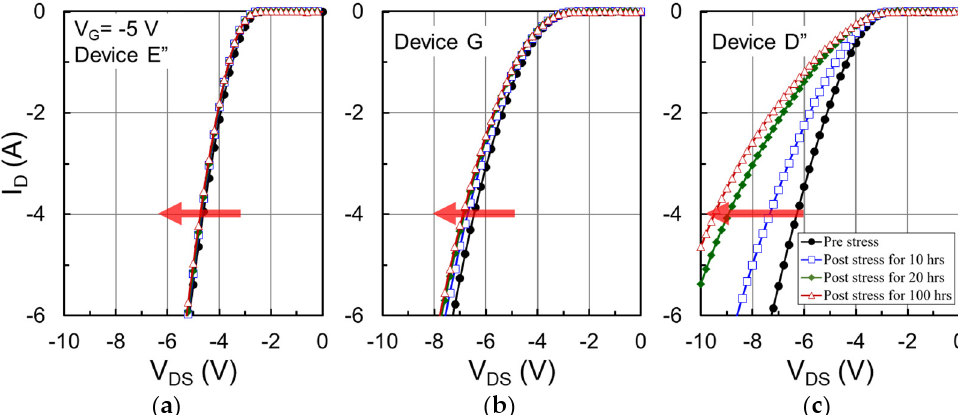
Figure 15. Third-quadrant I D -V D characteristics for built-in body diode of 1.7 kV SiC DMOSFET from three vendors. The body diodes were stressed at 5 A for ( a ) Device E” ( b ) Device G and 3.5 A for ( c ) Device D”.